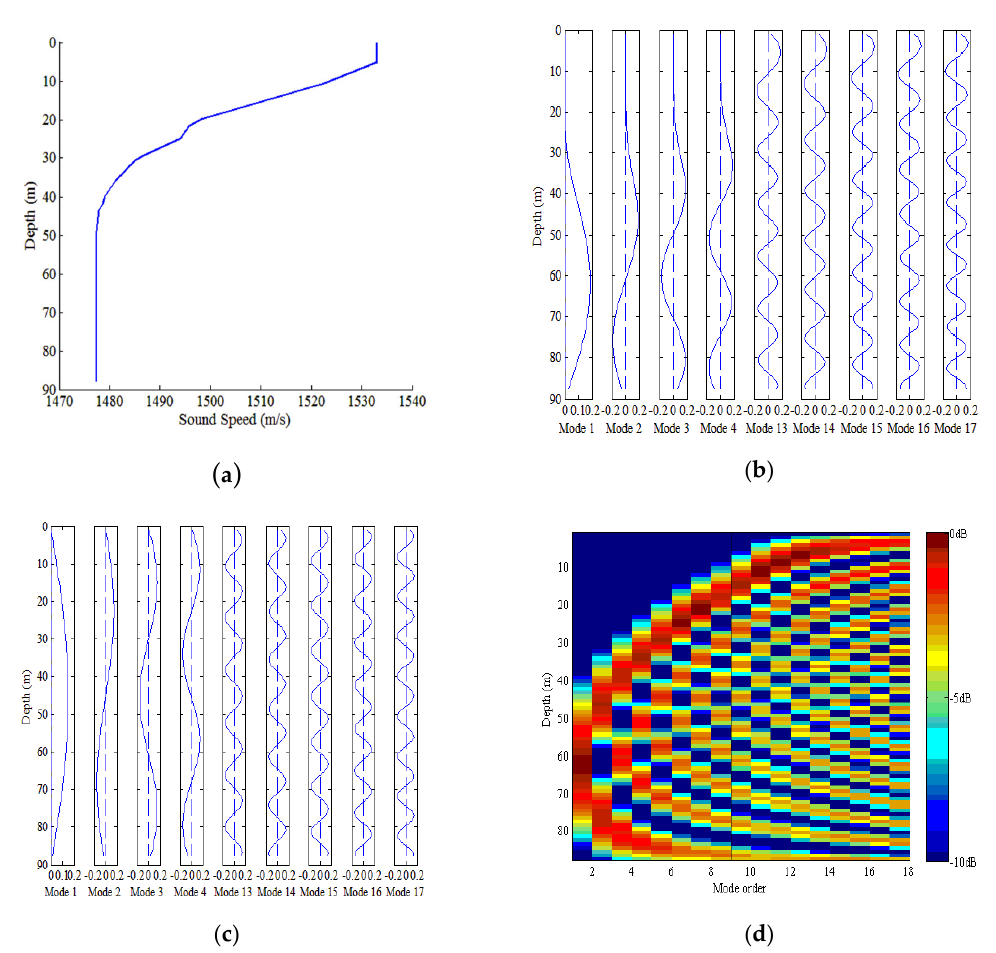
Figure 3. Characteristics of shallow water waveguide. ( a ) Sound speed profile (SSP) of typical summer shallow water waveguide. ( b ) Depth dependence of Mode Functions 1 – 4 and 13 – 17 for typical summer shallow water waveguide. ( c ) Depth dependence of Mode Functions 1 – 4 and 13 – 17 for typical winter shallow waveguide. ( d ) Normalized mode power for typical summer shallow water waveguide.